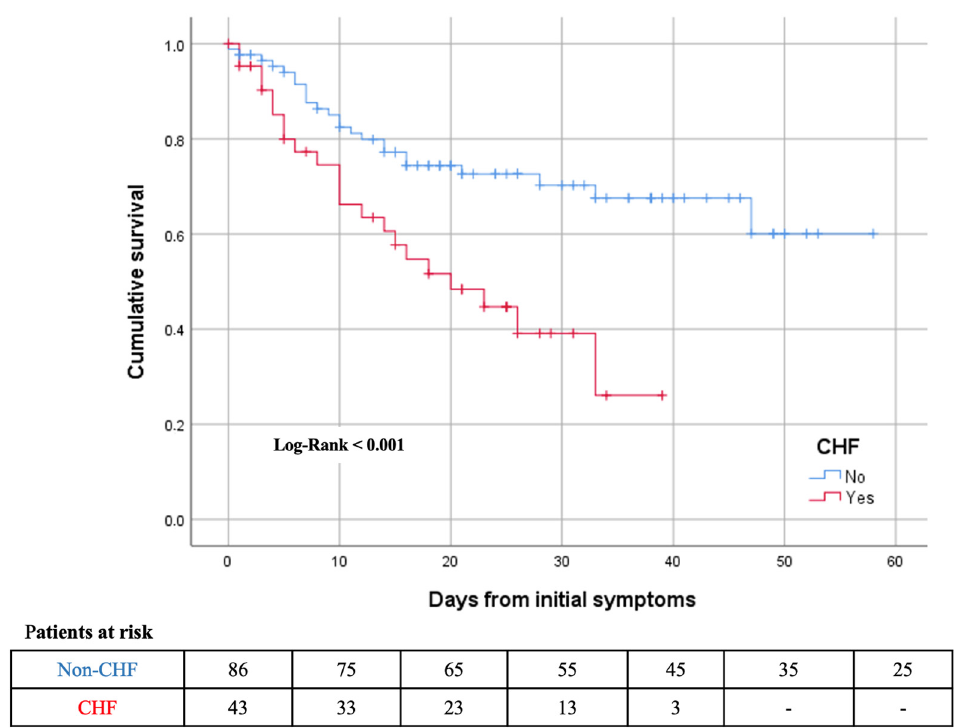
Figure 2. Kaplan–Meier 30-days survival curves for mortality by previous chronic heart failure (CHF) during time from initial symptoms.